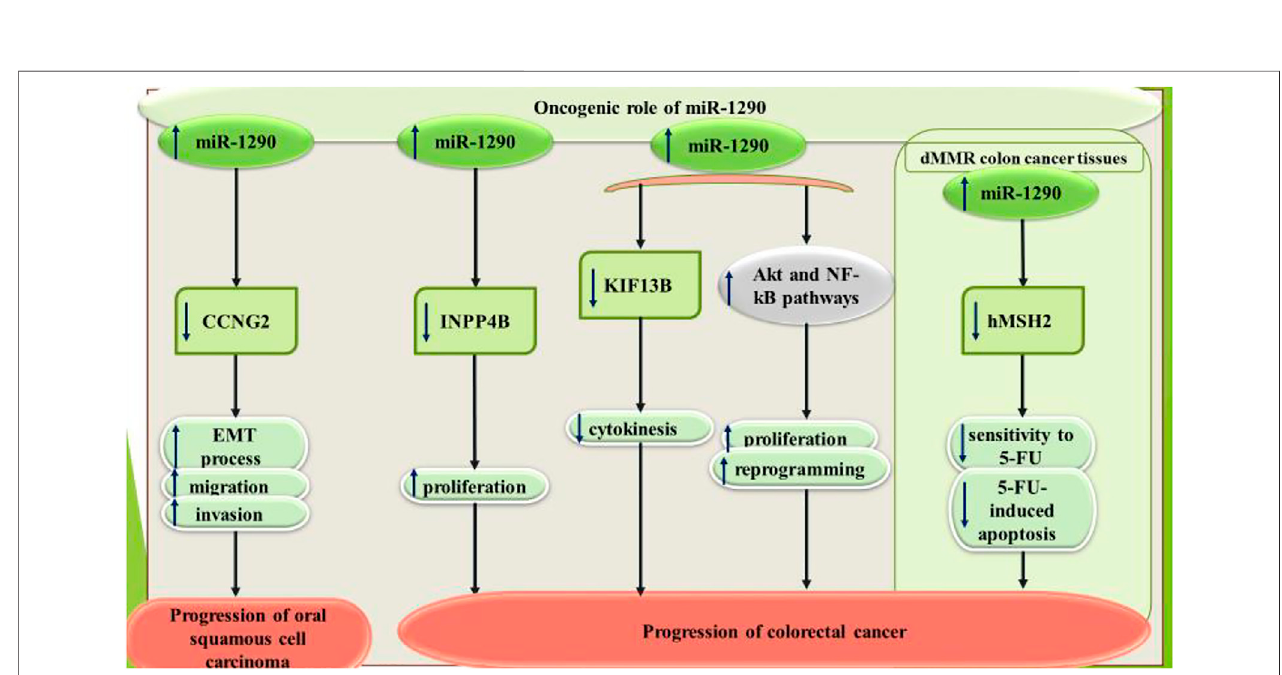
FIGURE 2 | Oncogenic in fl uence of miR-1290 in squamous cell carcinoma and colorectal cancer.